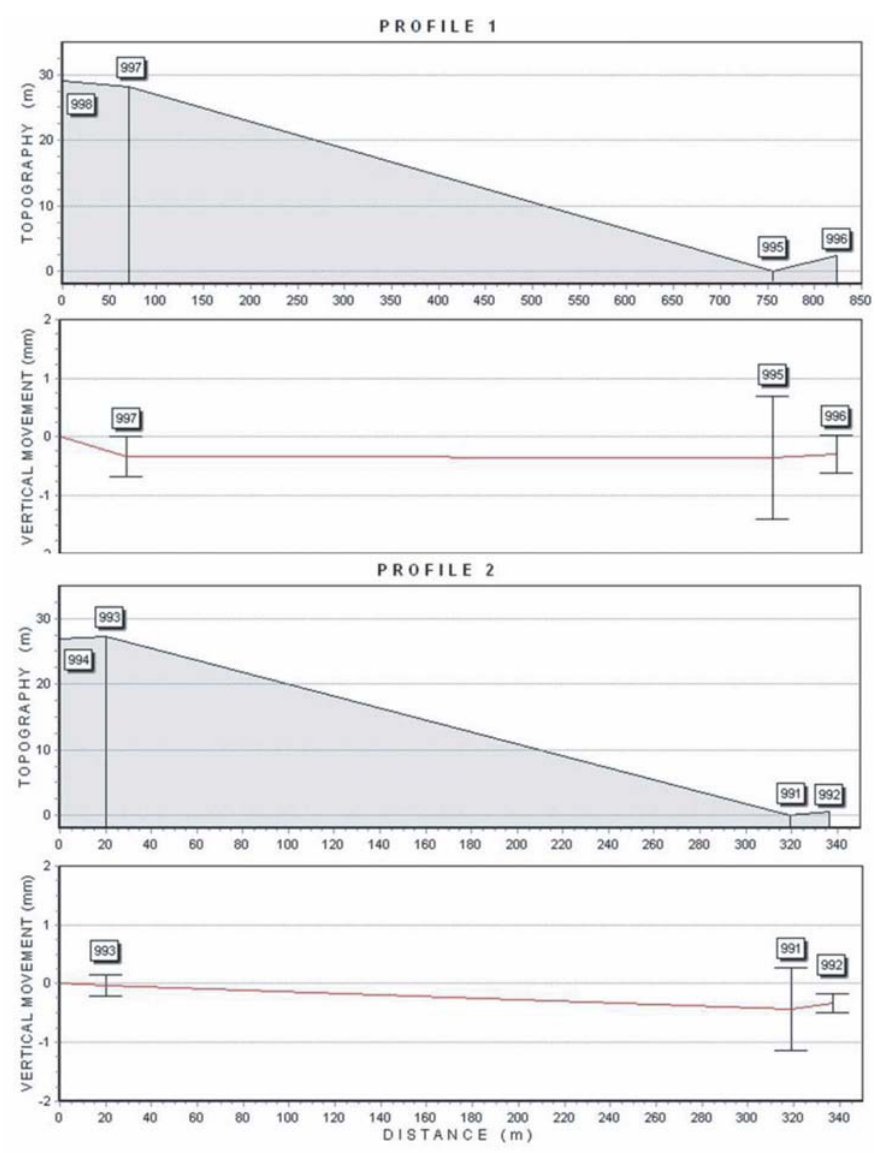
Figure 7. Recent vertical movement profiles in the Balanegra Fault